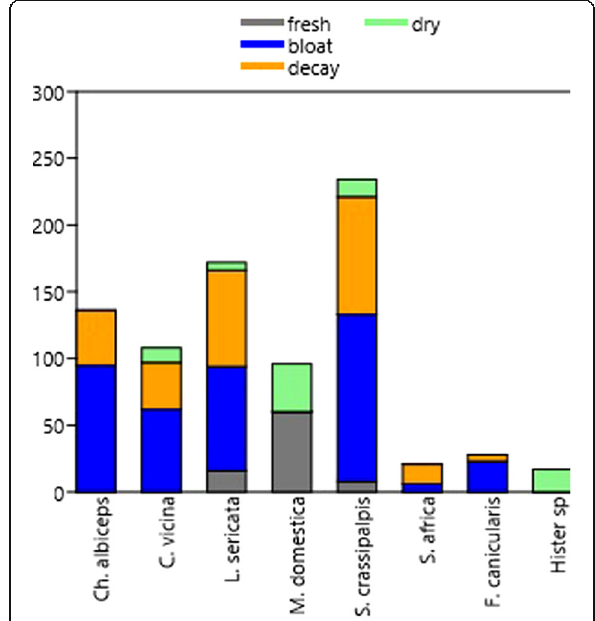
Fig. 4 Number of insect species collected in the indoor habitat during different stages of decomposition